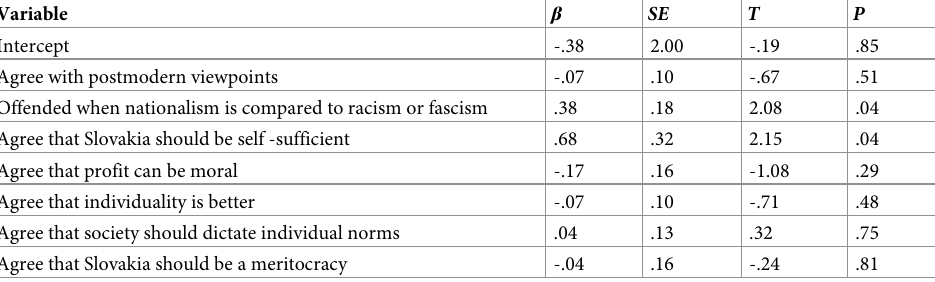
Table 5. Testing for identity fusion with key beliefs about self-sufficiency of Slovakia (controlling for other cul- tural beliefs).